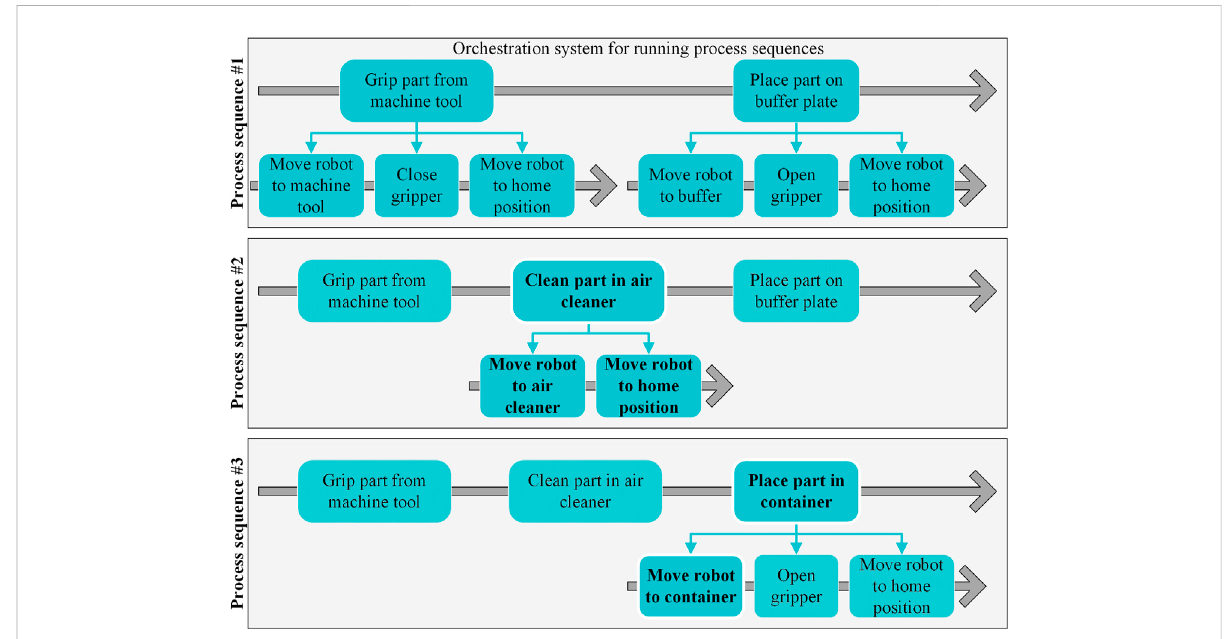
Example for modifying an automated process sequence of a robot cell with skill-based